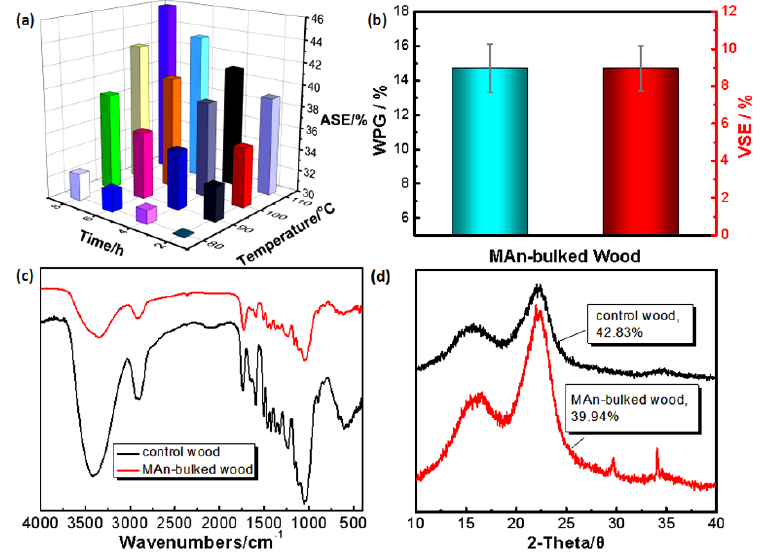
Figure 3. MAn bulking and reacting with wood cell wall. ( a ) Variations of the anti-swelling e ffi ciency (ASE) of the MAn-bulked wood under di ff erent reacting conditions; ( b ) the weight percent gain (WPG) and the volume swelling e ffi ciency (VSE) of wood bulked by MAn; ( c ) the FTIR spectra of the control wood and MAn-bulked wood; and ( d ) the XRD patterns of the control wood and the MAn-bulked wood. Both the reduction in water absorptivity (RWA) and anti-swelling e ffi ciency (ASE) of the